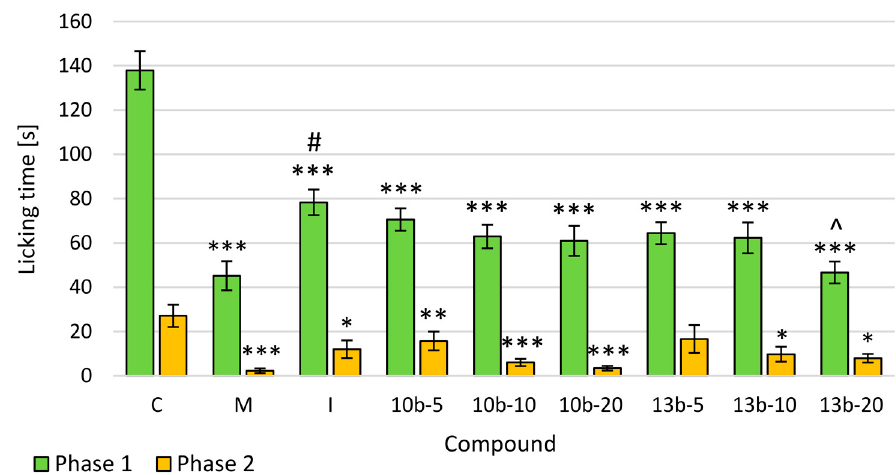
Figure 3. The effects of compounds 10b and 13b on the licking time in the early (0–5 min) and late (25–30 min) phases of the formalin test. Morphine and indomethacin were used as reference drugs. All compounds were administered intragastrically. Experimental groups ( n = 12): C—control group;